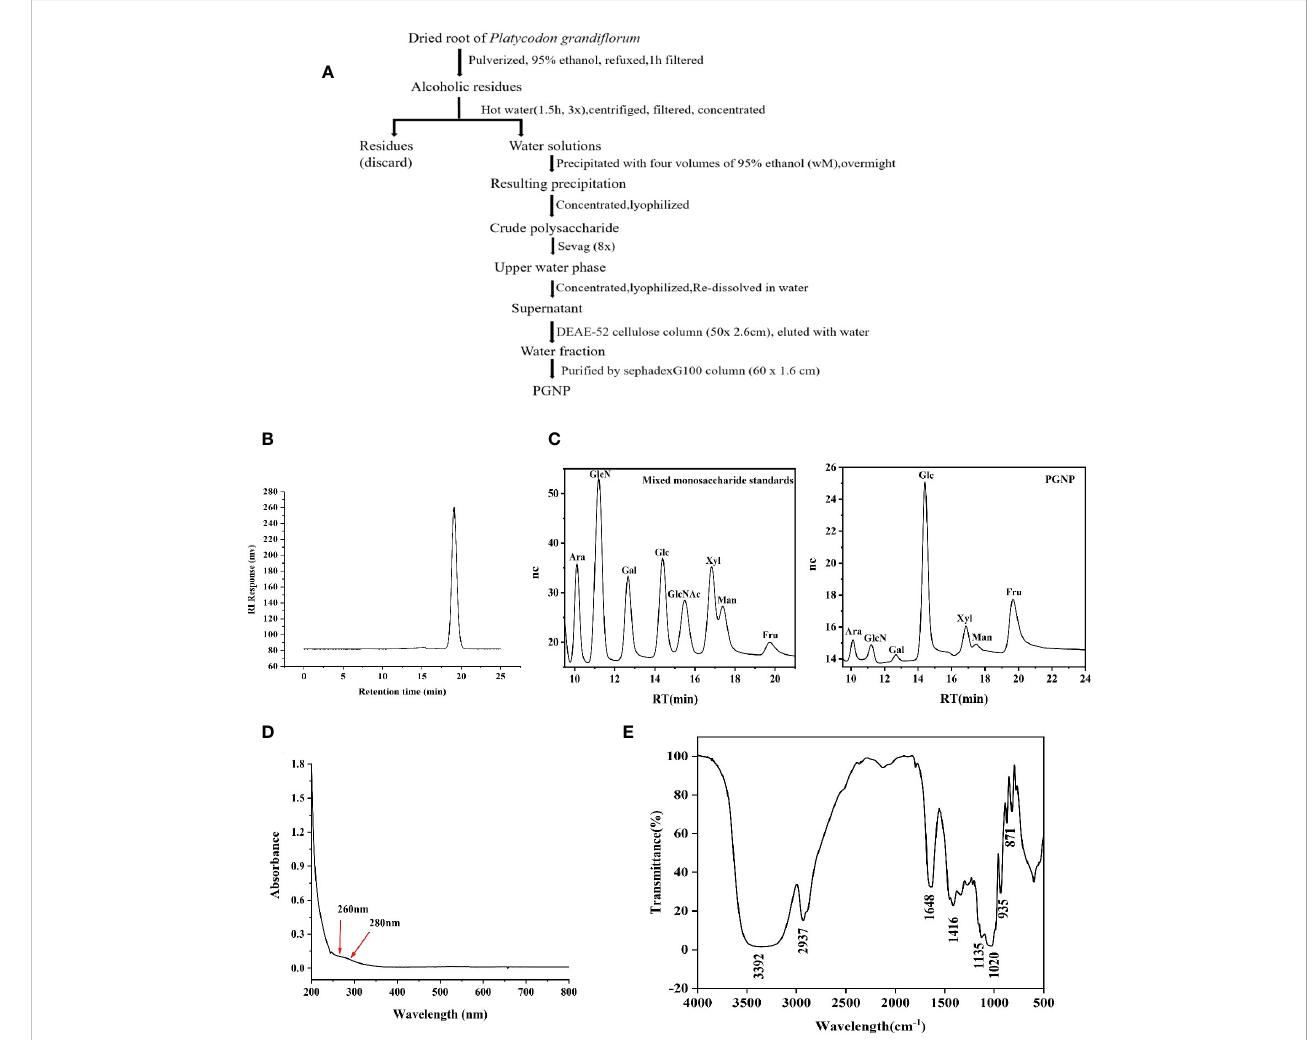
FIGURE 1 Extraction, puri fi cation, and characterization of polysaccharide PGNP from Platycodon grandi fl orum . Flow chart for the extraction and puri fi cation of PGNP (A) . HPLC chromatogram of PGNP demonstrating its molecular weight distribution (B) . Monosaccharide composition of PGNP identi fi ed by the IC chromatogram method. IC chromatograms of standard monosaccharides and PGNP (C) . Ultraviolet full wavelength scanning of PGNP (D) . FT-IR spectrum of PGNP (E)